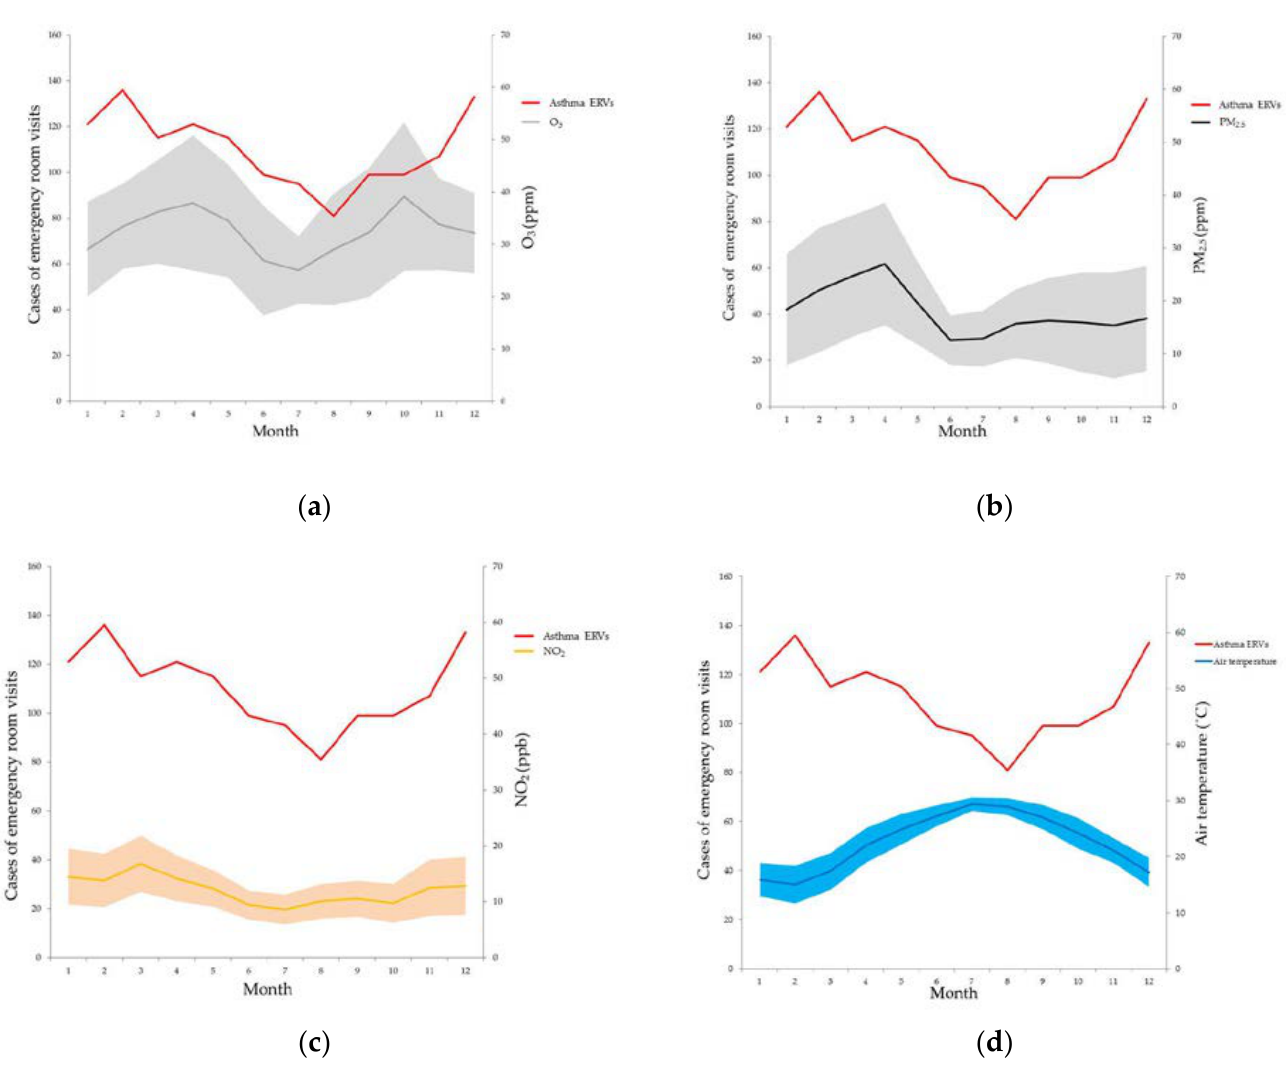
Figure 2. The asthma emergency room visits, ozone ( a ), PM 2.5 ( b ), NO 2 ( c ) and air temperature ( d ) in different months over four years in the Longtan district of Taoyuan in Taiwan.